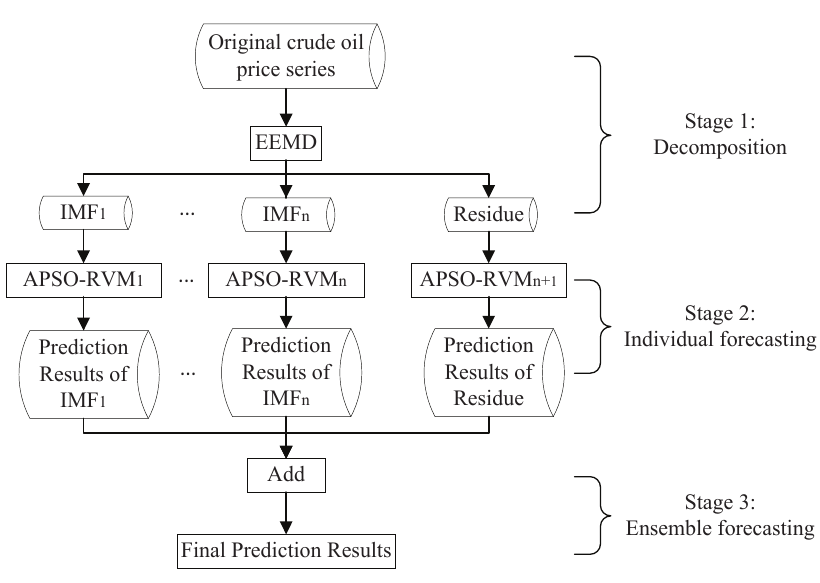
Figure 1. Flowchart for the proposed method. APSO: adaptive particle swarm optimization; EEMD: ensemble empirical mode decomposition; IMF: intrinsic mode function; RVM: relevance vector